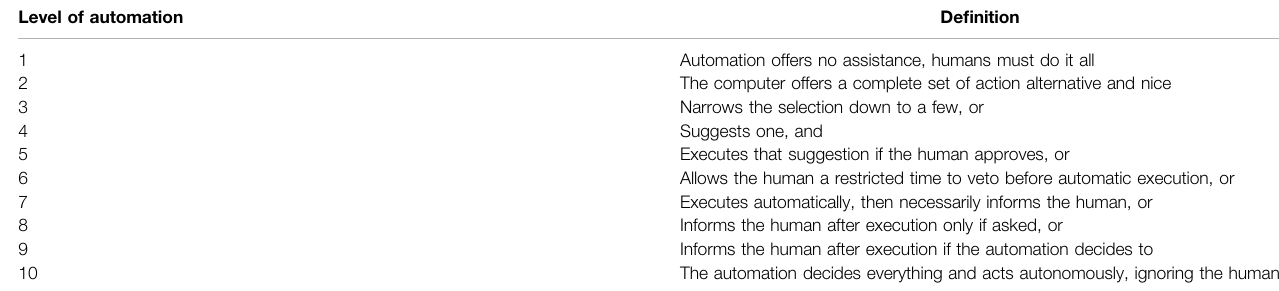
TABLE 1 | Sheridan and Verplank ’ s (1978) LOA structured